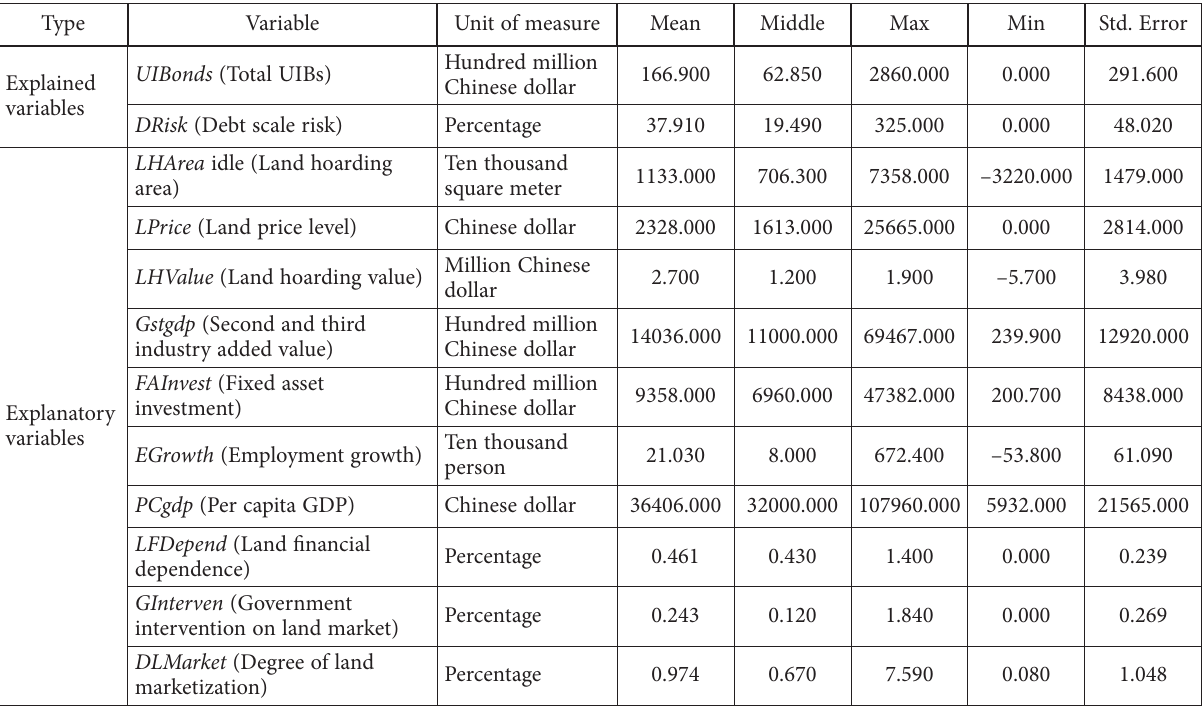
Table 1. Descriptive statistics of the variables